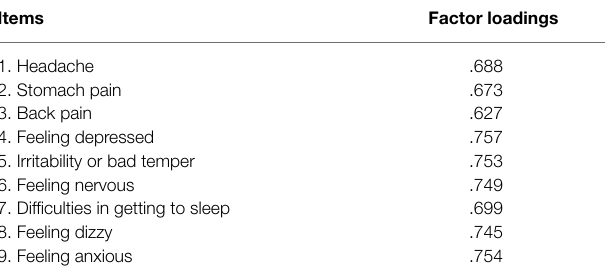
TABLE 3 | Reliability and construction validity of general health ( N = 63,228).